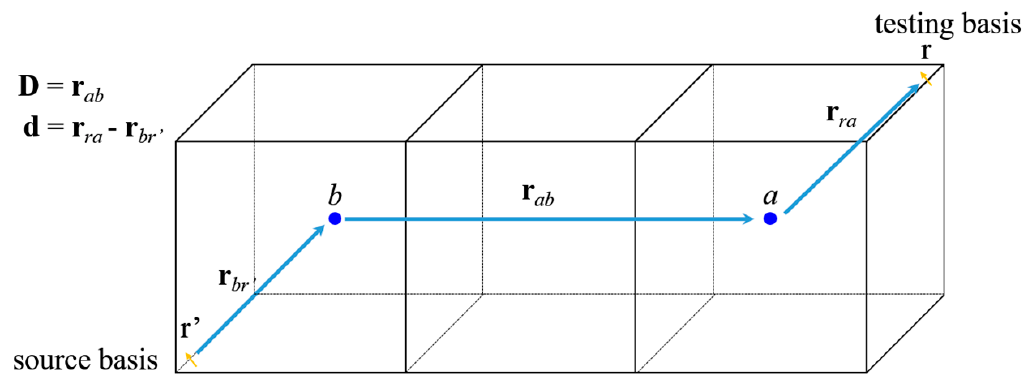
Figure 3. The worst case when the ratio | D | to | d | is minimal in the conventional cube grouping. On the other hand, in the K-means clustering, basis functions are evenly assigned to the clusters, which are determined randomly and iteratively based on the standard Euclidean distance criteria [18]. The ratio of | D | to | d | is thus increased, as shown in Figure 4, which compares the histograms of the ratio of | D | to | d | for 3 m radius sphere CAD model with 50,000 basis functions. The accuracy of MLFMA approximation is also increased for the numerical implementation of the truncated value of L .